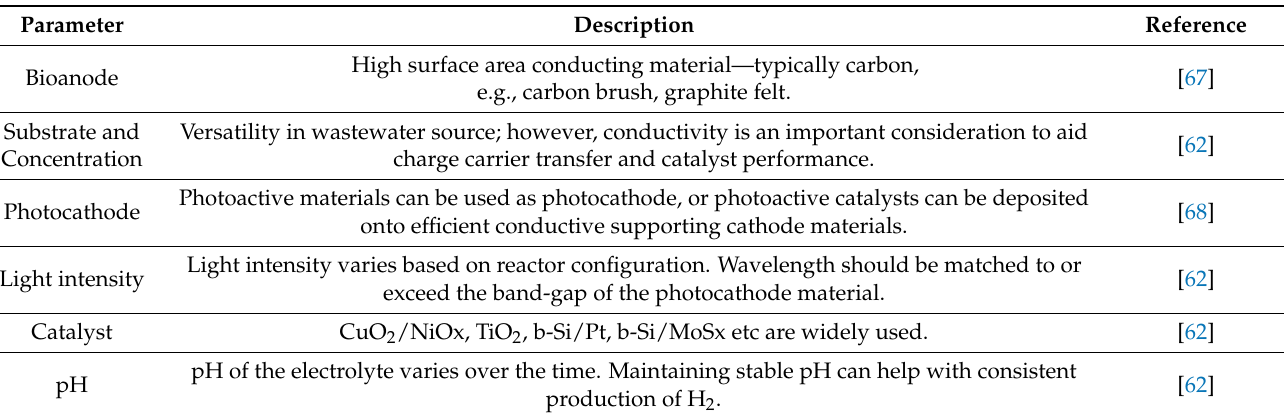
Table 7. Key parameters influencing H 2 production via an MPEC.